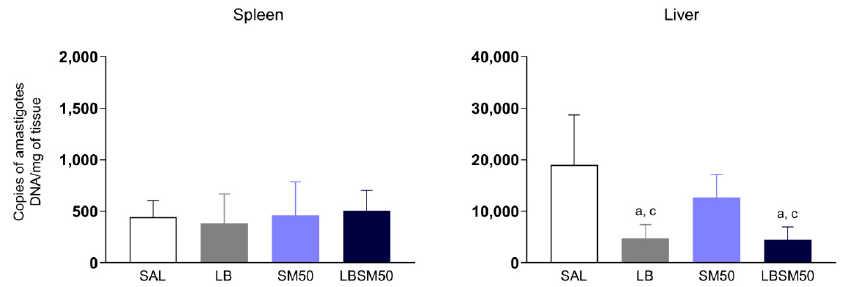
Figure 7. Parasite load in immunized BALB/c mice’s spleen and liver 28 days post-challenge with L. (L.) infantum ( n = 10/group) expressed in copies of amastigotes DNA per milligram (mg) of